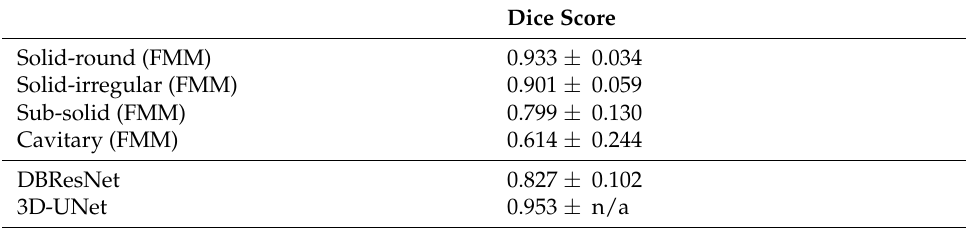
Table 7. Comparison between the fast marching method (FMM), DBResNet and